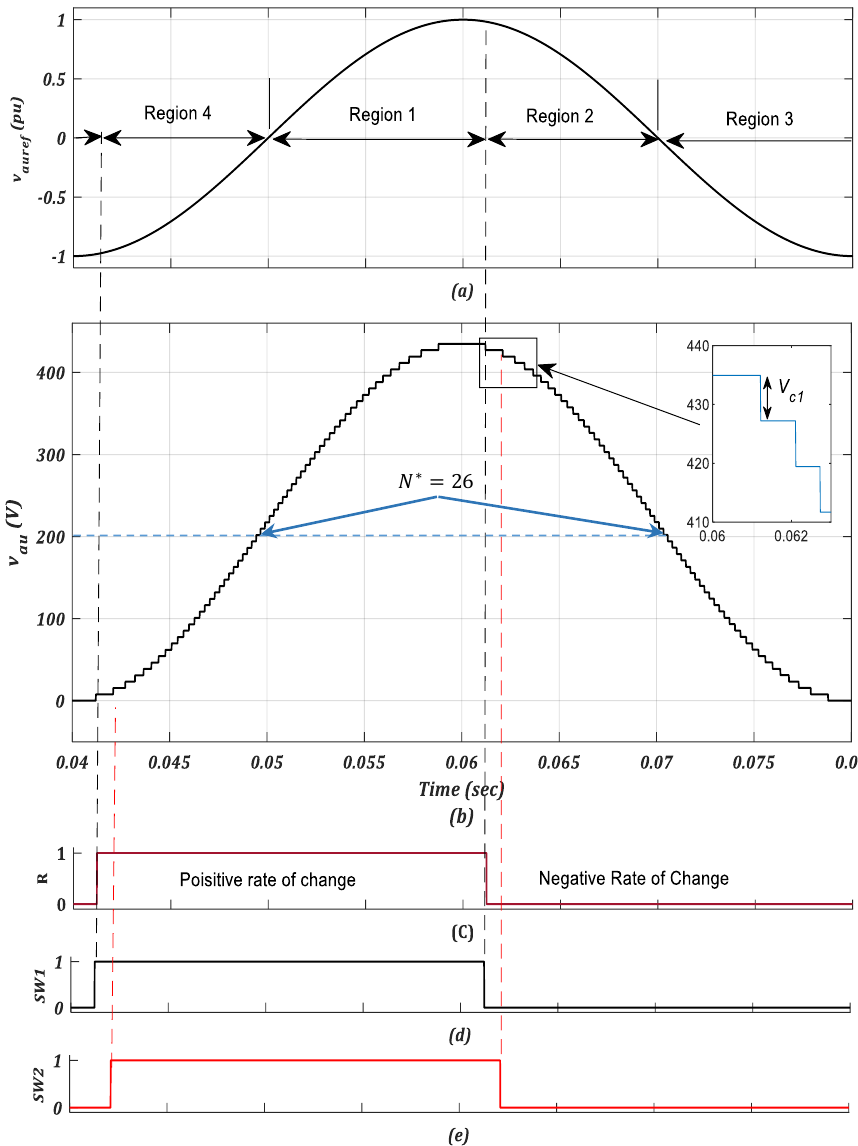
Figure 13. ( a ) Phase A upper arm voltage reference; ( b ) actual arm voltage of phase A upper arm; ( c ) rate of change in arm voltage; ( d ) battery 1 switching period; ( e ) battery 2 switching period.